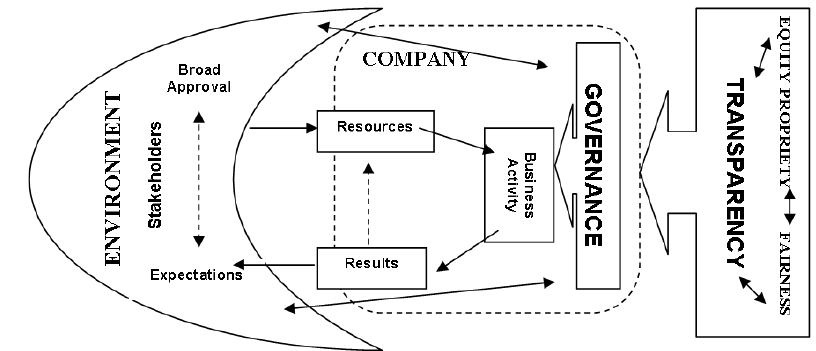
Figure 1: Conditions for Effective